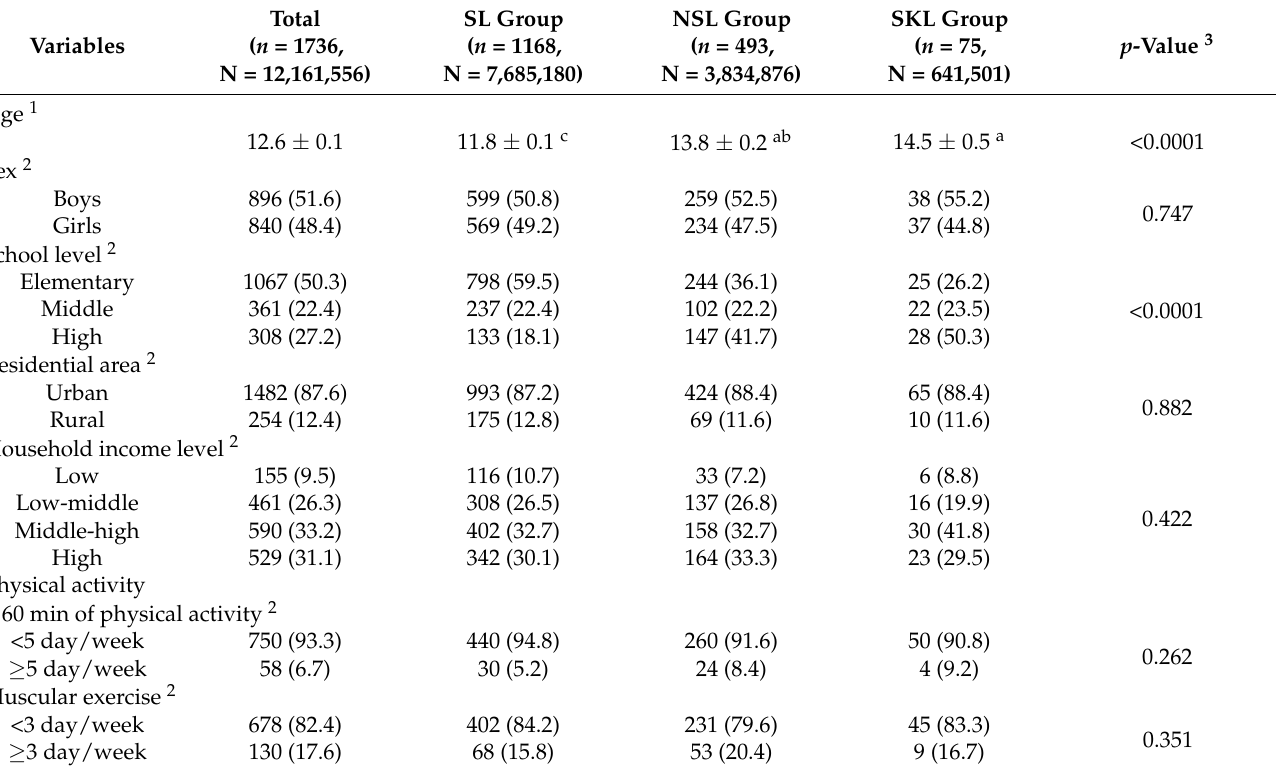
Table 1. Sociodemographic characteristics among children and adolescents in South Korea.